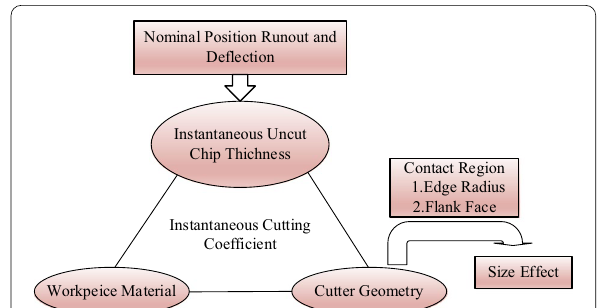
Figure 20 Factors related to instantaneous cutting